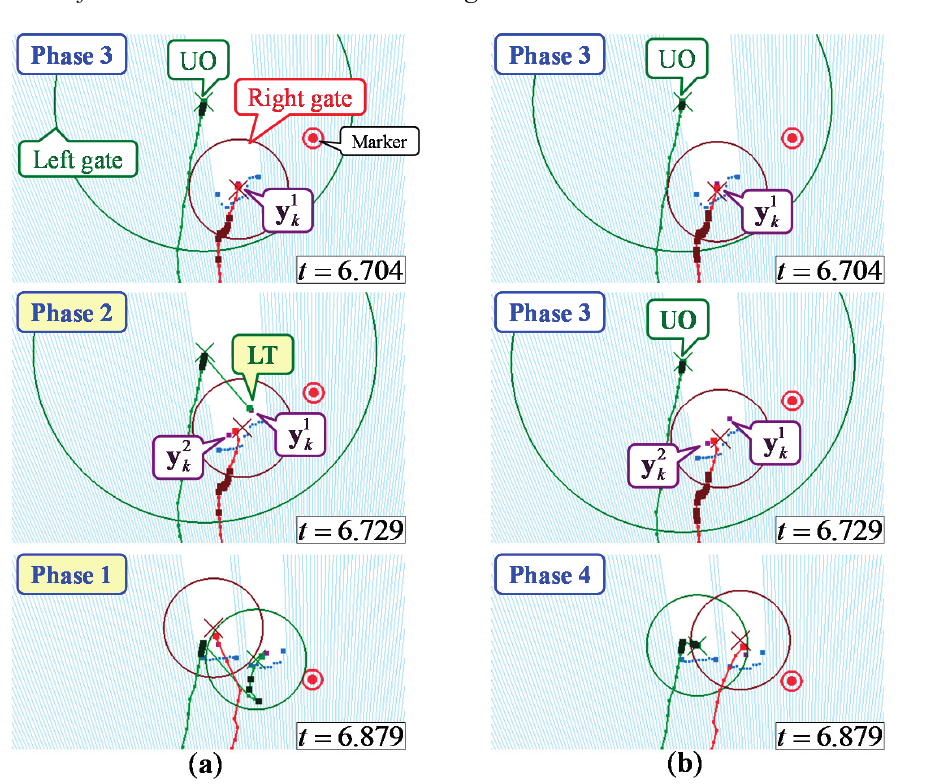
Figure 12. Leg tracking result in a situation where the left leg was temporarily hidden and LRS distance data were disturbed. ( a ) Method 1: global nearest neighbor (GNN) data association. ( b ) Method 2: data association considering gait